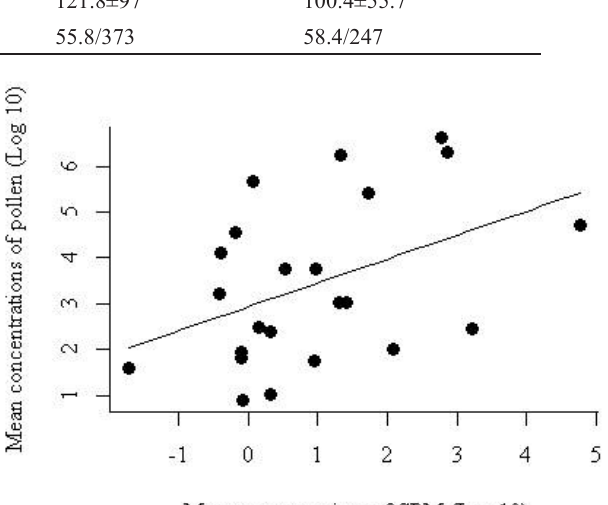
Fig 2 . Relationship between mean concentration of metals on pollen and in Suspended Particulate Material